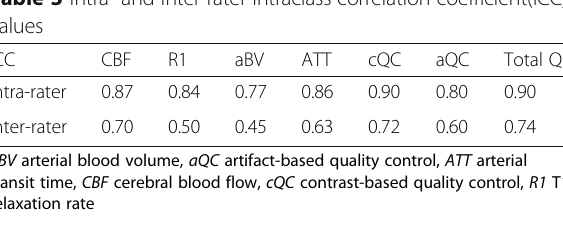
Table 3 Intra- and inter-rater intraclass correlation